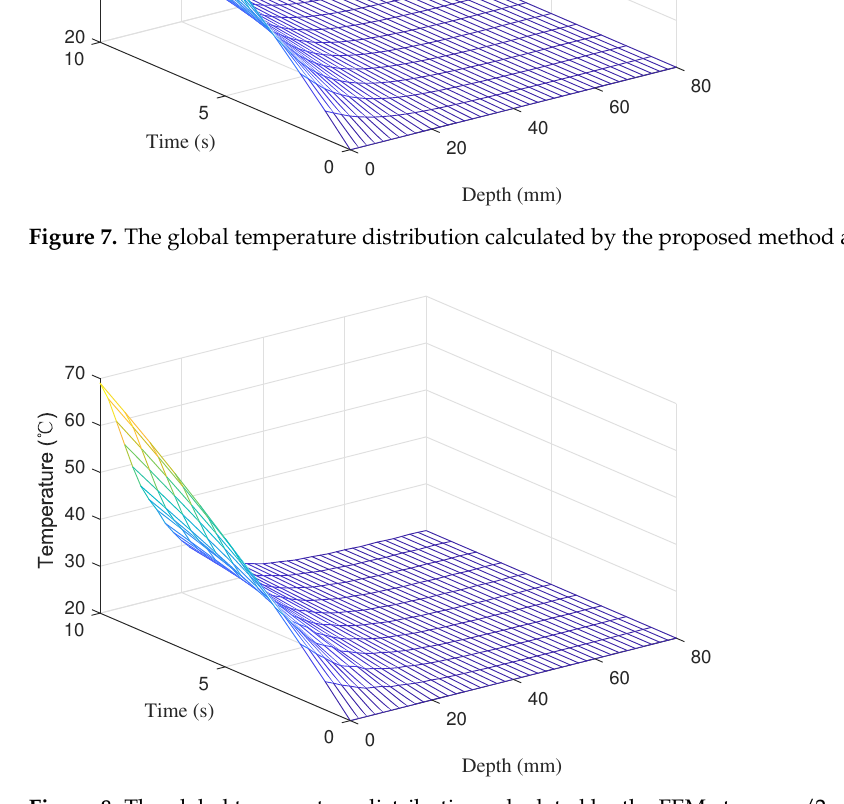
time curves at different depths ( z = 0, 20, 40, and 60 mm) are shown in Figure 9. The temperature distributions in the z -axis direction at different moments ( t = 2, 4, 6, and 8 s) are shown in Figure